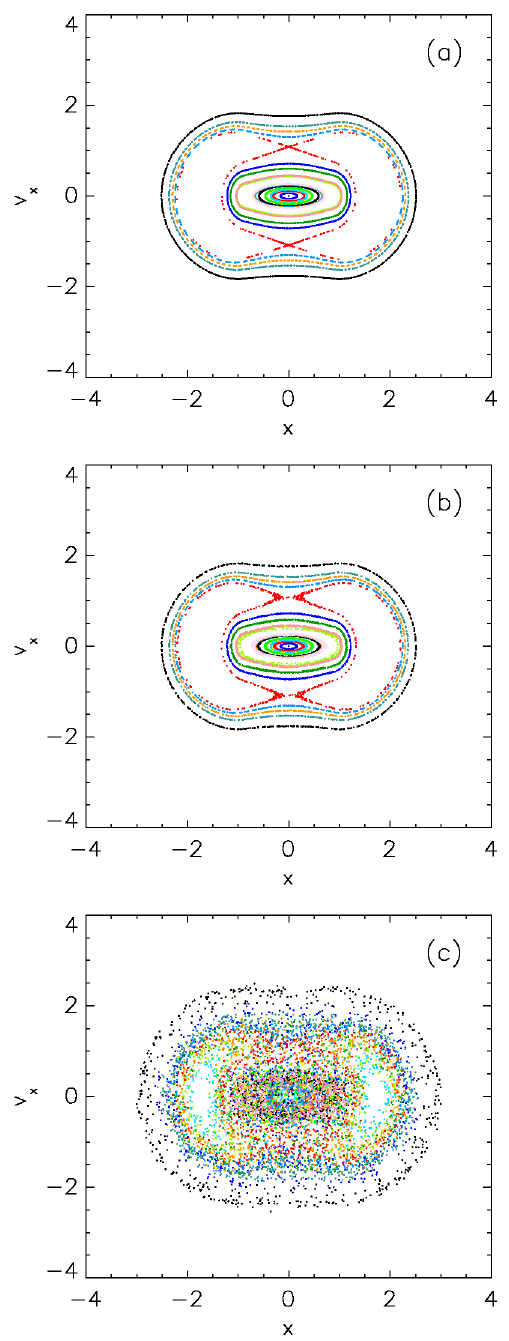
FIG. 10. (Color) Poincare´ sections for a set of 18 representa- tive initial conditions in an envelope-mismatched beam inte- ) with various grated over t (cid:2) 2048 DE units ( (cid:1) 250 t D noise strengths, and with M (cid:2) 1 : 1118 : (a) hj (cid:22)! ji (cid:2) 0 , (b) hj (cid:22)! ji (cid:2) 10 (cid:4) 3 , and (c) hj (cid:22)! ji (cid:2) 10 (cid:4) 1 from equilibrium. Subsequent charge redistribution will trigger a hierarchy of collective modes. Unavoidable ir- regularities in the beam line will impose a spectrum of colored noise that adds self-consistently to the time- dependent potential associated with the collective modes.